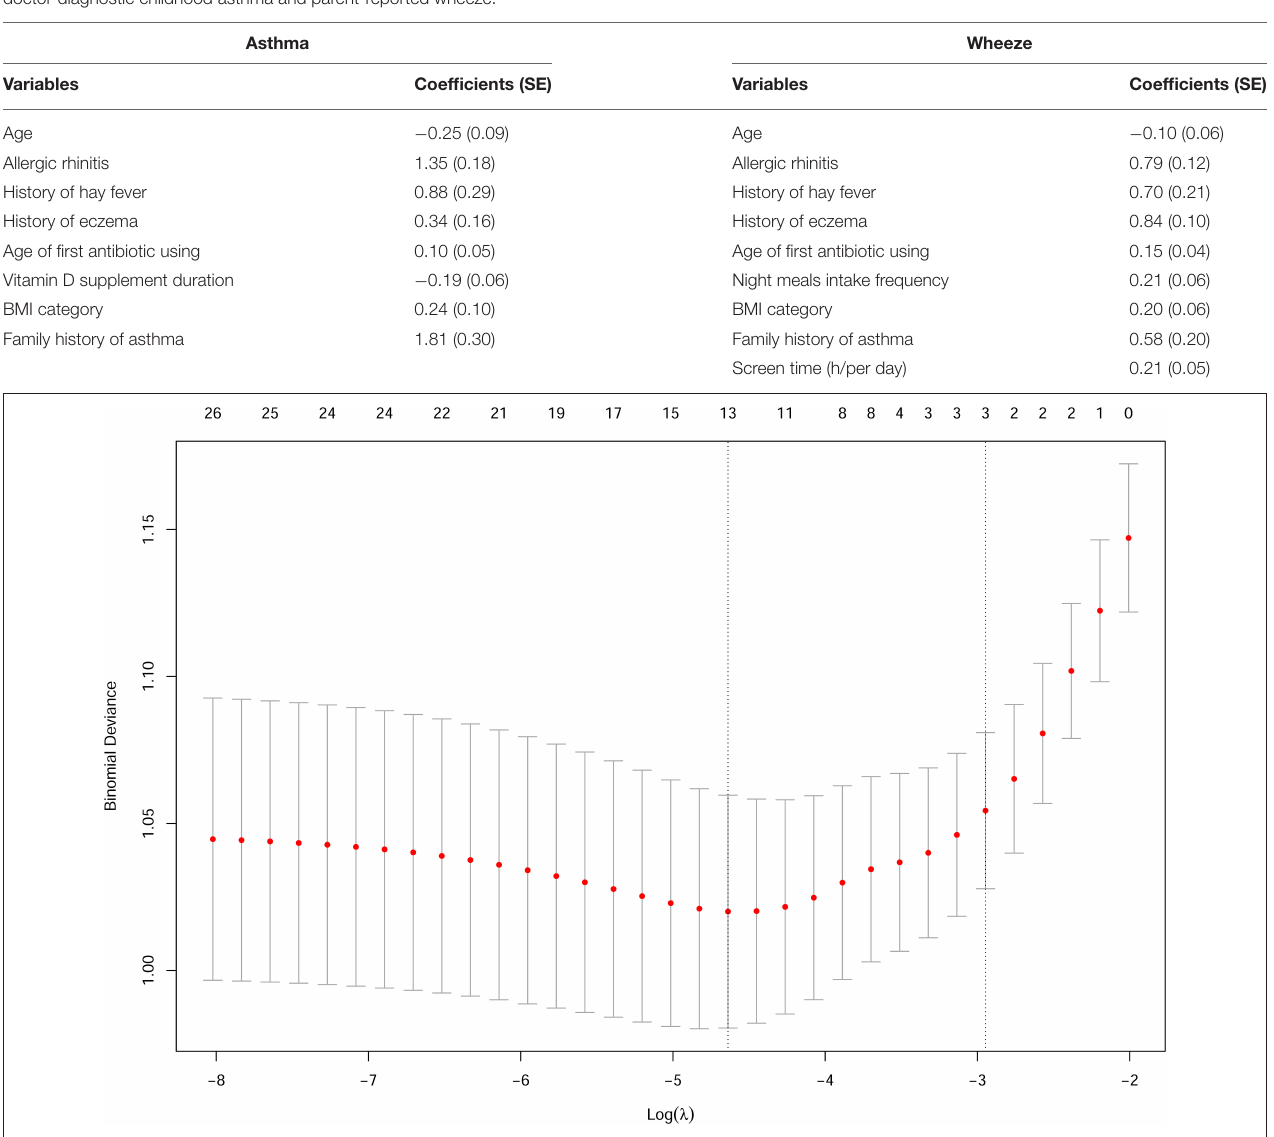
FIGURE 1 | Cross validation plot for the penalty term for childhood